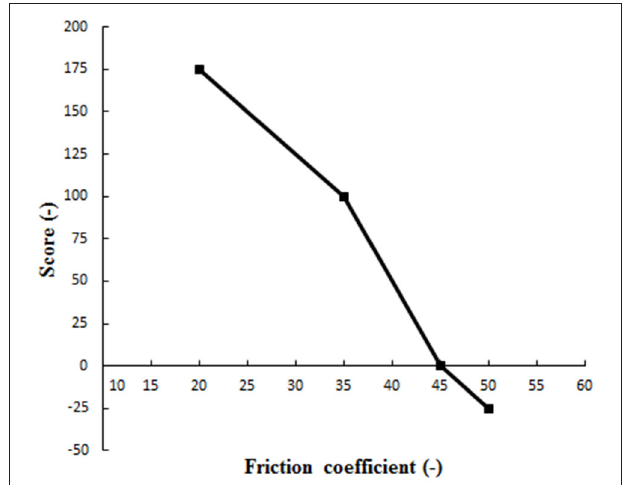
FIGURE 2 | Friction coefficient value